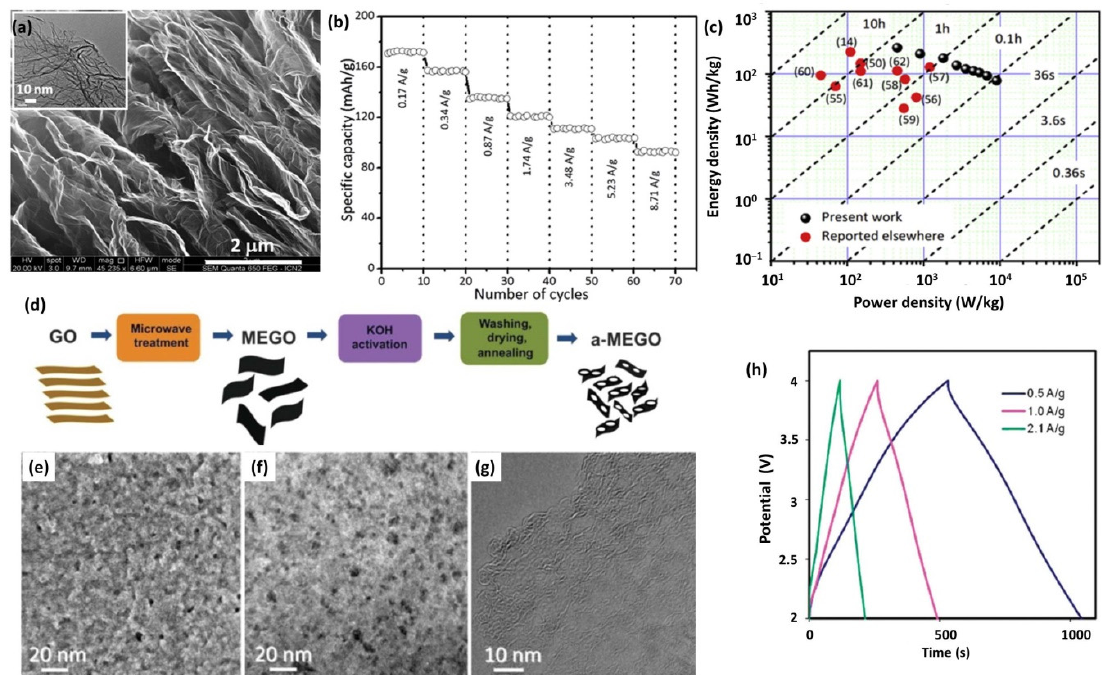
Figure 4. ( a ) FESEM of PRGO (inset shows TEM image); ( b ) Rate capability of PRGO; ( c ) Ragone plot for PRGO-based LICs. Reproduced with permission from Ref. [67]. Copyright 2018, Elsevier. ( d ) Schematic showing the microwave exfoliation/reduction of GO and the following chemical activation of MEGO with KOH; Images of ( e ) high-resolution SEM, ( f ) ADF-STEM and ( g ) high-resolution phase contrast electron micrograph of a-MEGO. Reproduced with permission from Ref. [110]. Copyright 2011, American Association for the Advancement of Science. ( h ) Charge/discharge curves for a-MEGO/graphite LICs at various current densities. Reproduced with permission from Ref. [123]. Copyright 2012, Royal Society of Chemistry.